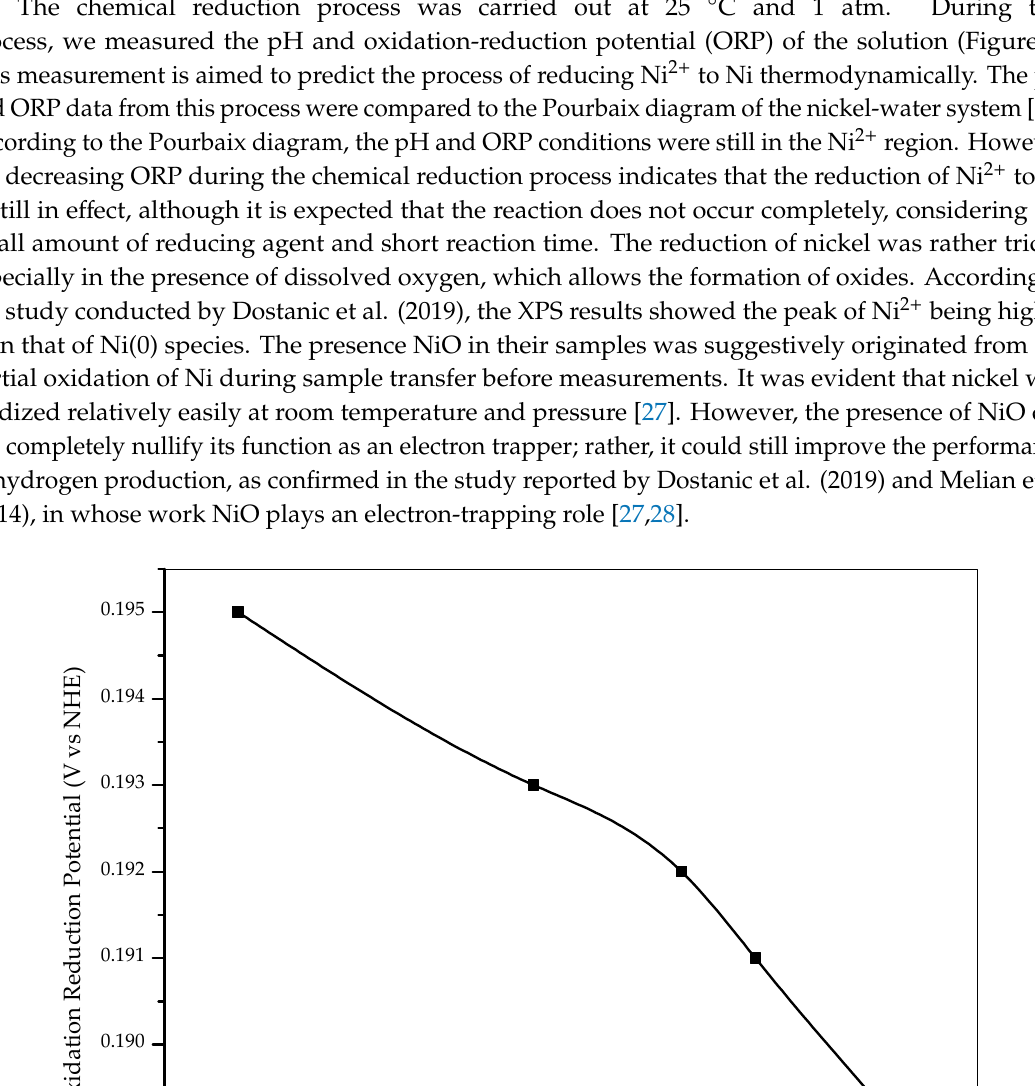
Table 2. Bandgap Energy of Photocatalysts.